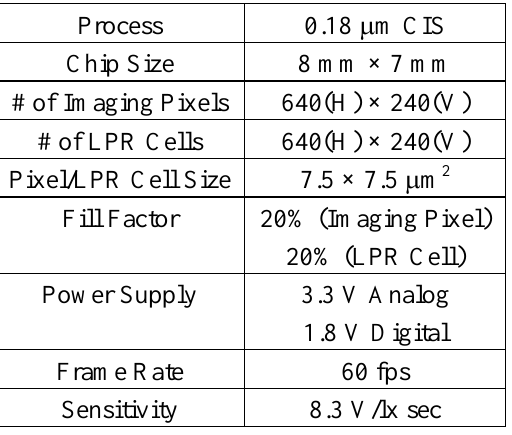
Table 2. Parameters of fabricated